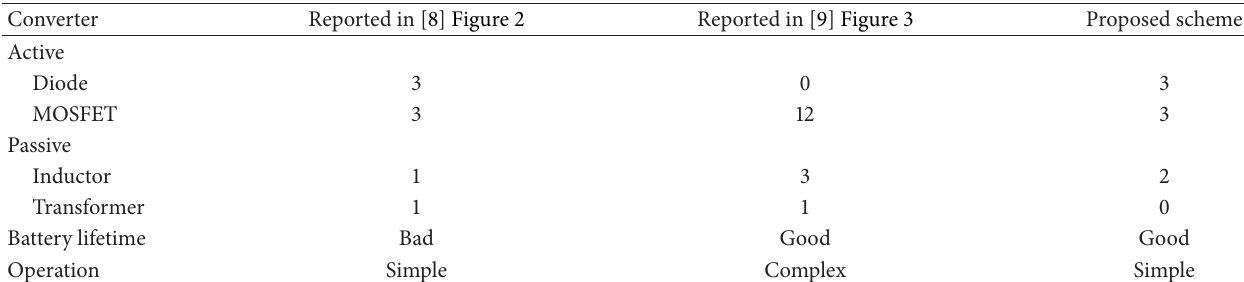
Table 3: Comparison between converters.